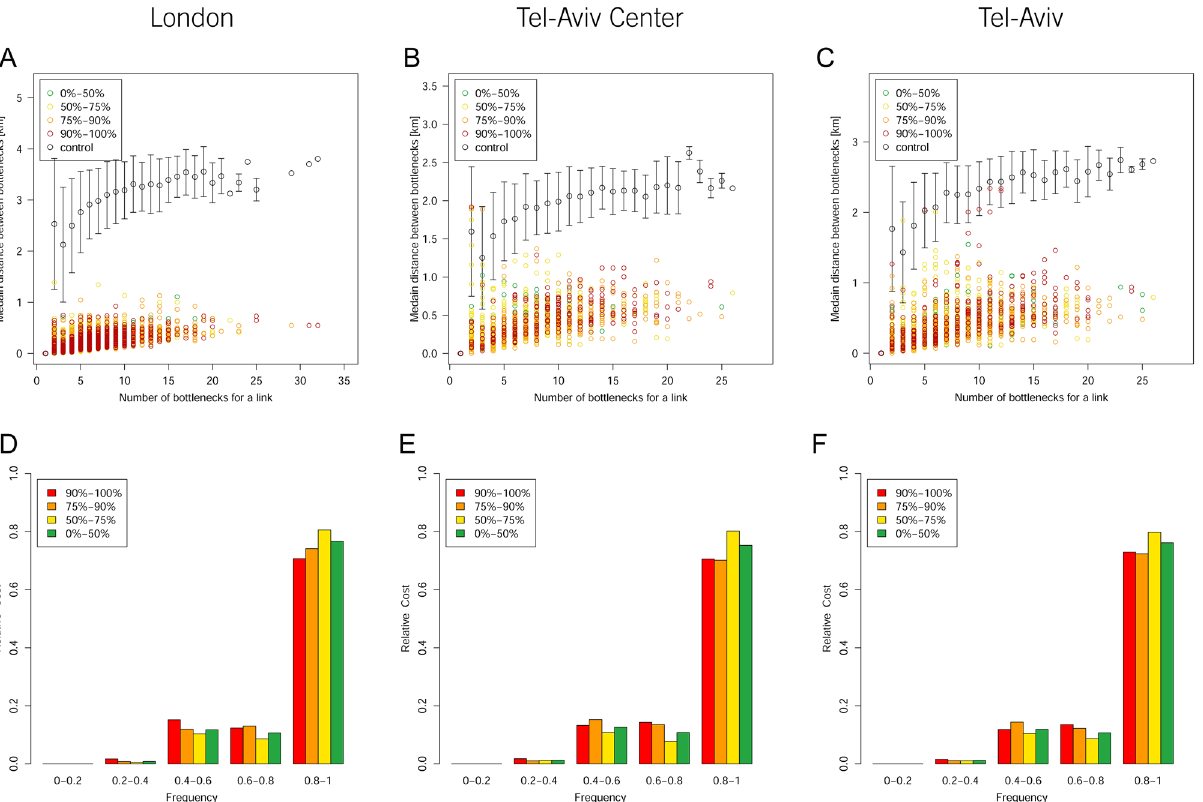
Figure 3. Top: the streets that were included in any of the JT during the examined week. The X-axis represents the number of different bottlenecks each street was connected to, the Y-axis represents the median distance between these bottlenecks, and the colors represent the relative percentage TotalCost RJT (Eq. 4) of each street, in comparison to the other streets in the dataset. The control group is calculated by allocating a number of random bottlenecks to each street as the number of different bottlenecks it was connected to. ( A ) London ( B ) Tel Aviv Center ( C ) Tel Aviv. Bottom: the distribution of the frequency of the relative CumulativeCost ( t ) JT (Eq. 3), i.e., for each tree, the value of the trunk with the highest CumulativeCost ( t ) JT , divided by the sum of the CumulativeCost ( t ) JT of all the branches that acted as trunks for this tree are presented for ( D ) London ( E ) Tel Aviv Center ( F ) Tel Aviv. The colors represent the level of costs of the